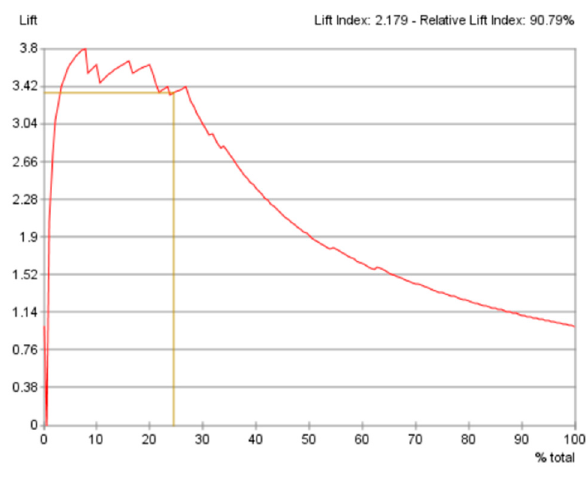
Figure 12. Lift curve.